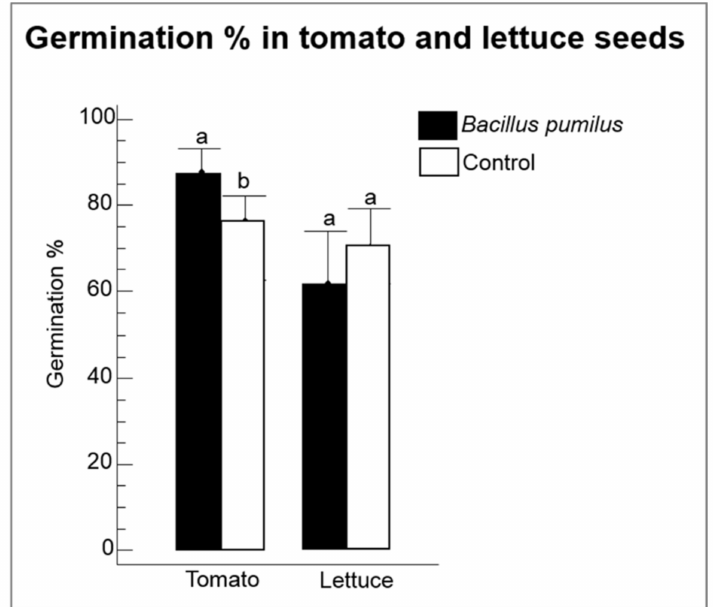
Figure 3. Effect of Bacillus pumilus on the germination of tomato and lettuce seeds. Error bars represent the standard deviation. The different letters indicate statistically significant differences between the Tukey treatments for p ≤